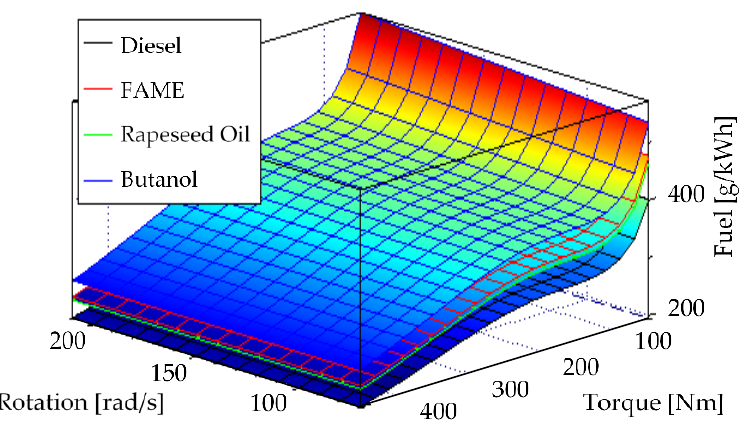
Figure 4. Model of specific fuel consumption characteristics built with the use of a neural network and used in further simulations.